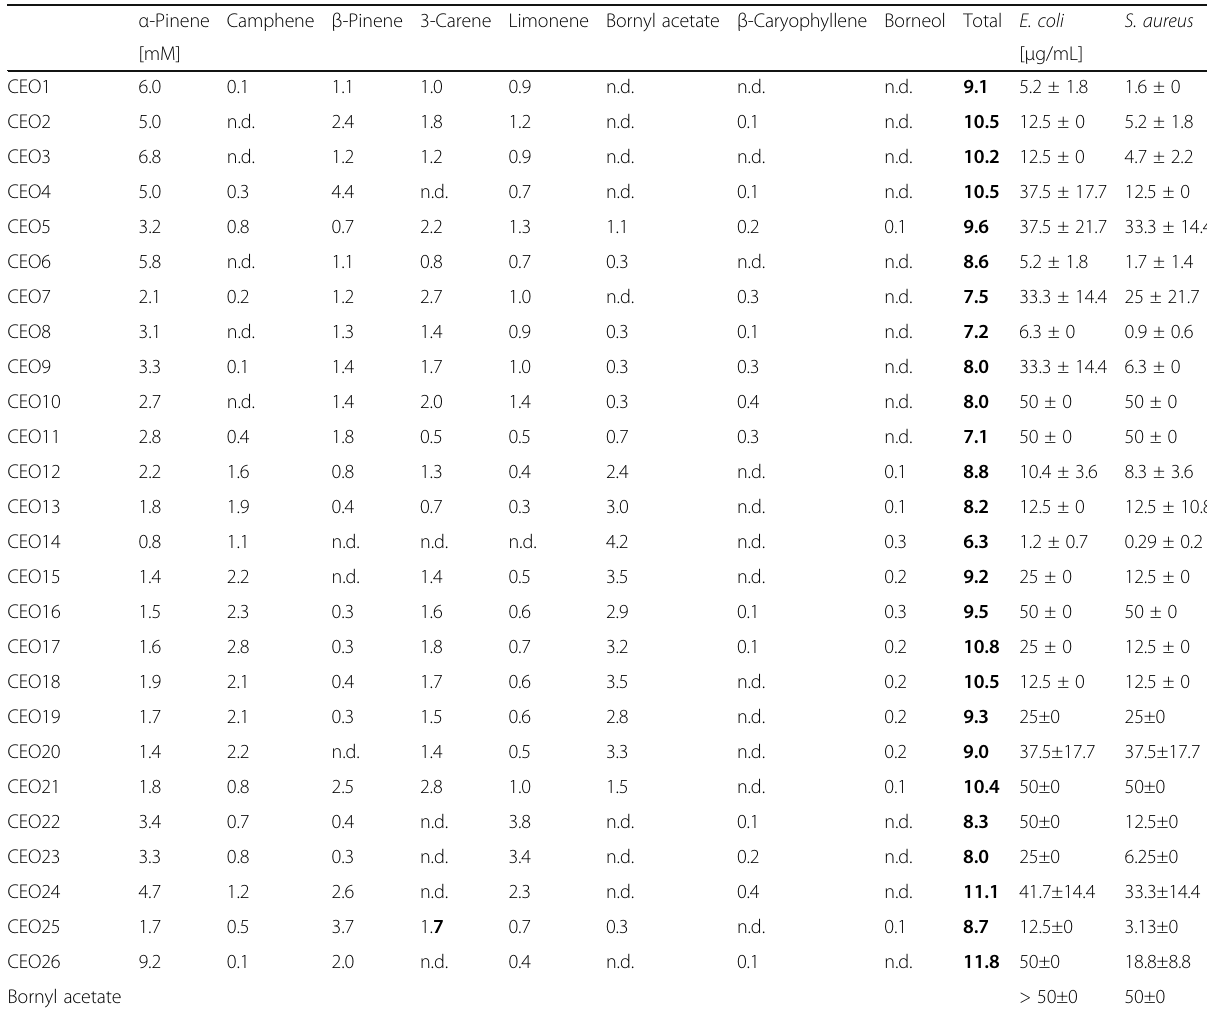
Table 2 Absolute concentration [mM] of the terpenes and MIC [ μ g/mL] ( n = 3) from the tested CEOs against E. coli and S. aureus , n.d. not